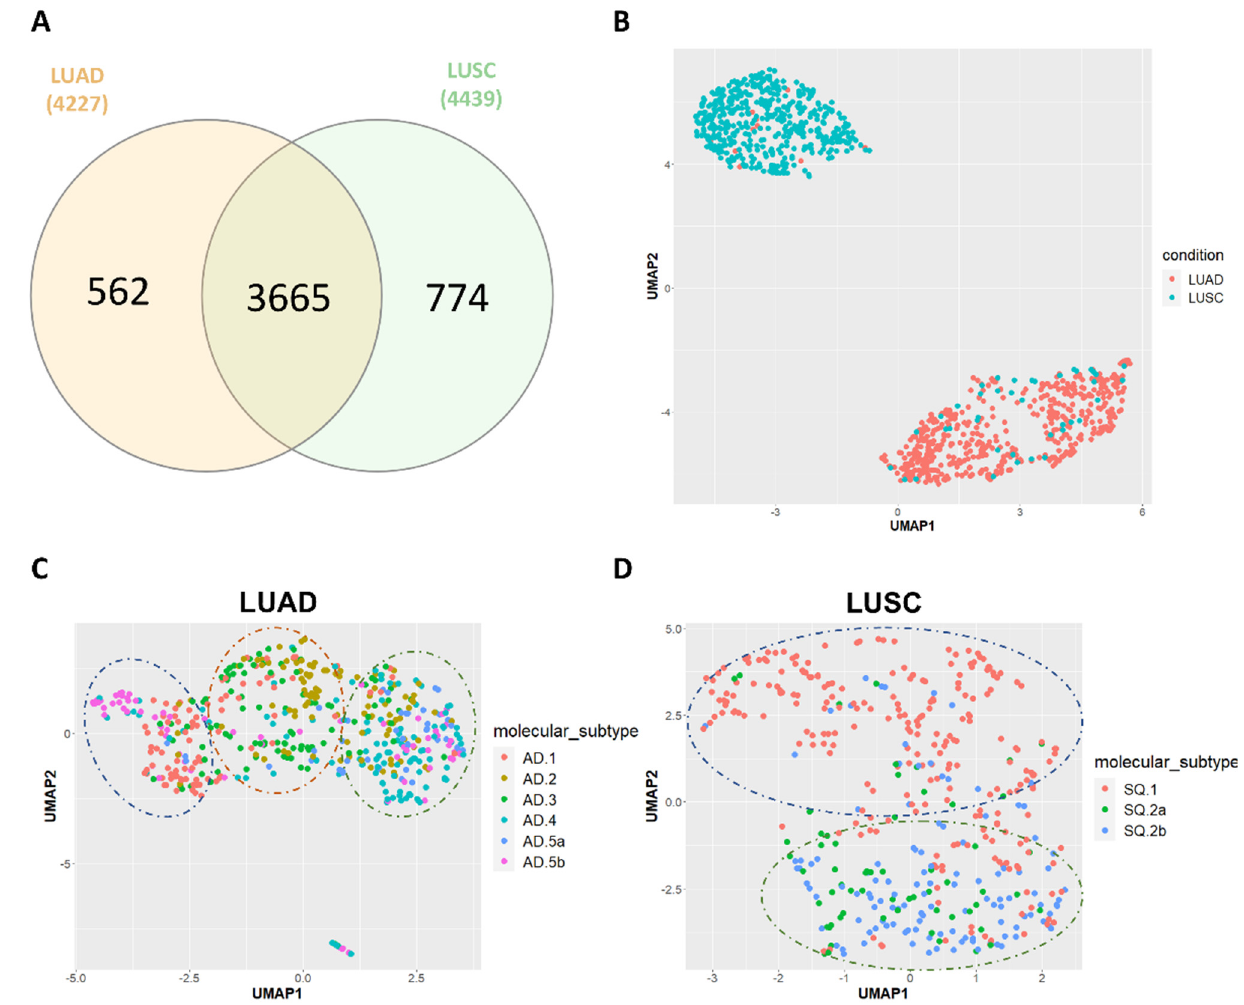
Figure 1. ( A ) Venn diagram showing the number of expressed HERVs identified exclusively in TCGA − LUAD, and TCGA − LUSC, and in common between two cohorts; ( B ) UMAP representation based on the top 100 most variable HERVs showing that TCGA − LUAD (red) and TCGA − LUSC (light blue) sample cohorts form two well-separated different clusters; UMAP representation based on the top 100 most variable HERVs in TCGA − LUAD ( C ) and TCGA − LUSC ( D ), showing the association between HERV expression and molecular subtypes.